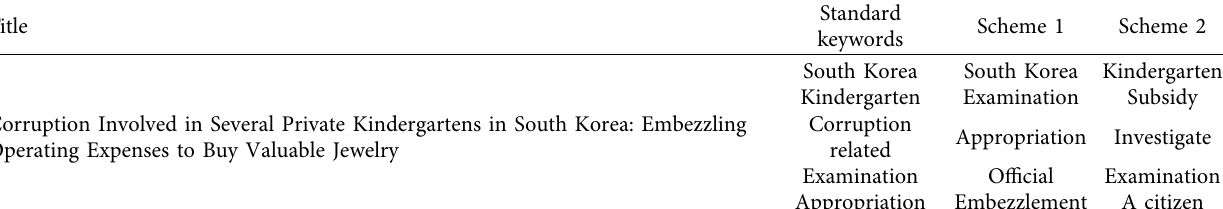
Table 2: Comparison of experimental results.